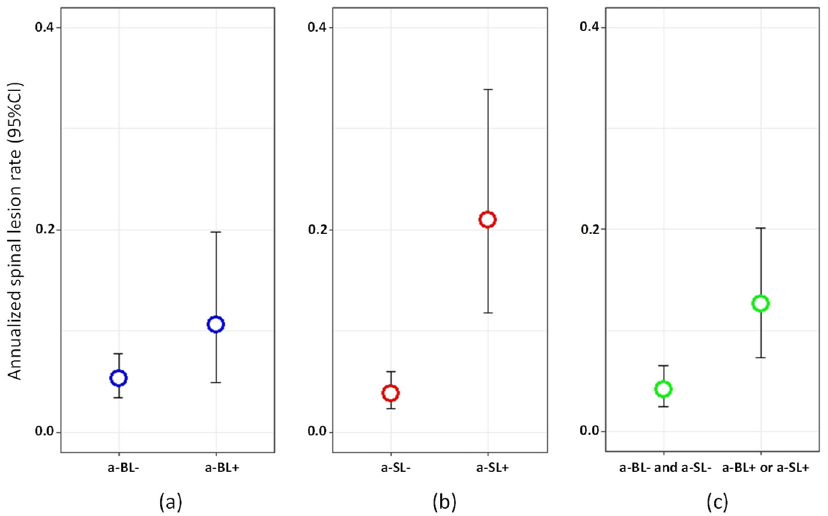
Figure 4. Annualized spinal lesion rate between T2 and T3 in: ( a ) patients with vs. without asymptomatic brain lesions (a-BL) at T2; ( b ) patients with vs. without asymptomatic spinal lesions (a-SL) at T2; ( c ) patients with either a-BL or a-SL vs. neither a-BL nor a-SL at T2.